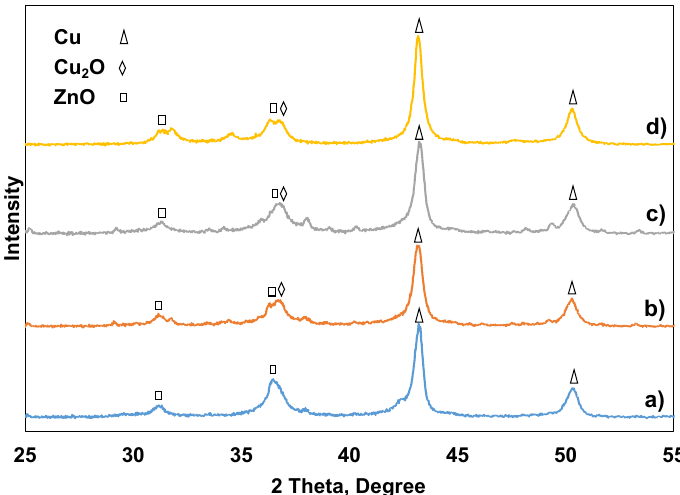
Table 4. Activities of the recycled catalysts 1 .